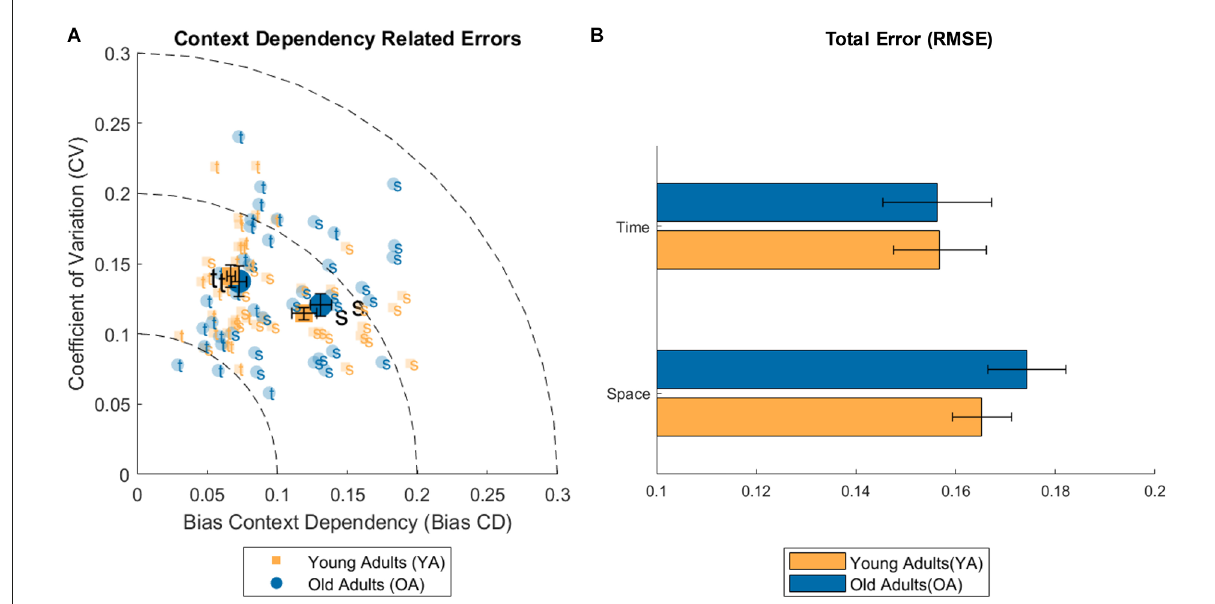
FIGURE4 (A) Plot of the individual data for Bias and coefficient of variation (CV) related to the context dependency phenomenon (error bars represent the Standard Error of the mean). (B) Bar plot of the root mean squared error (RMSE) for the spatial and temporal condition and both age groups (error bars represent the Standard Error of the